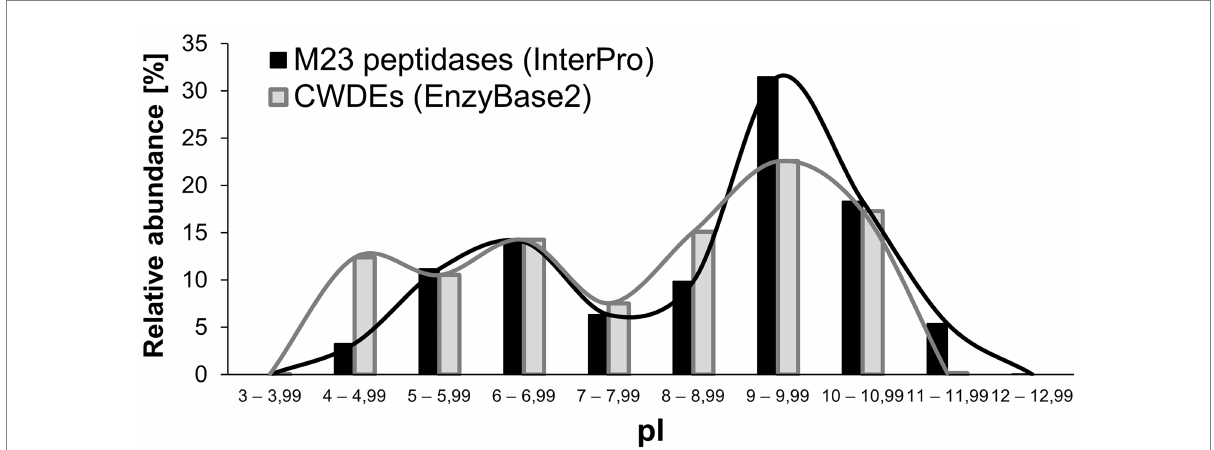
FIGURE 4 Calculated isoelectric points of M23B bacterial peptidoglycan hydrolases in comparison to the isoelectric points of cell-wall degrading enzymes (CWDEs) gathered in the EnzyBase2 database. Values are presented both in chart bars and lines, the latter serves to illustrate the presence of maxima in each dataset.